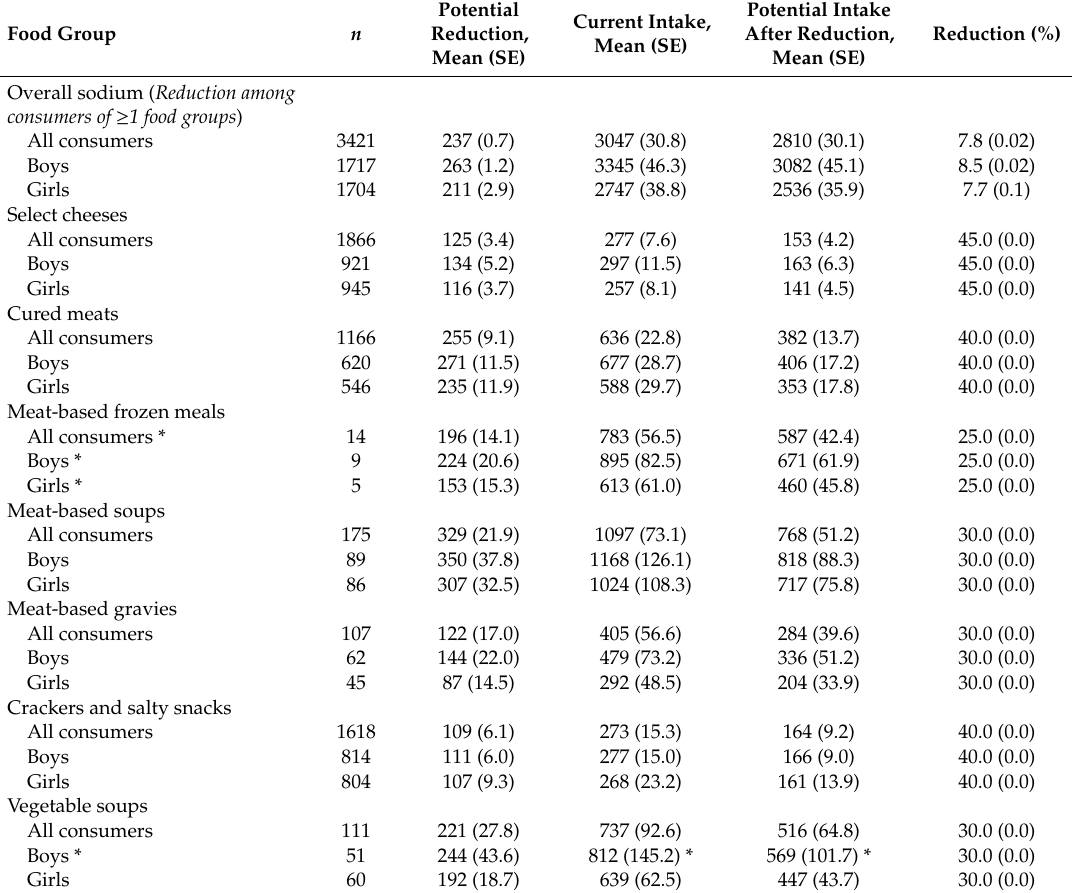
Table 7. Potential sodium intake reduction with MSG in the diets of U.S. children (aged 1–18 years) who consume selected food groups by age and select food group, NHANES 2013–2016 1,2,3